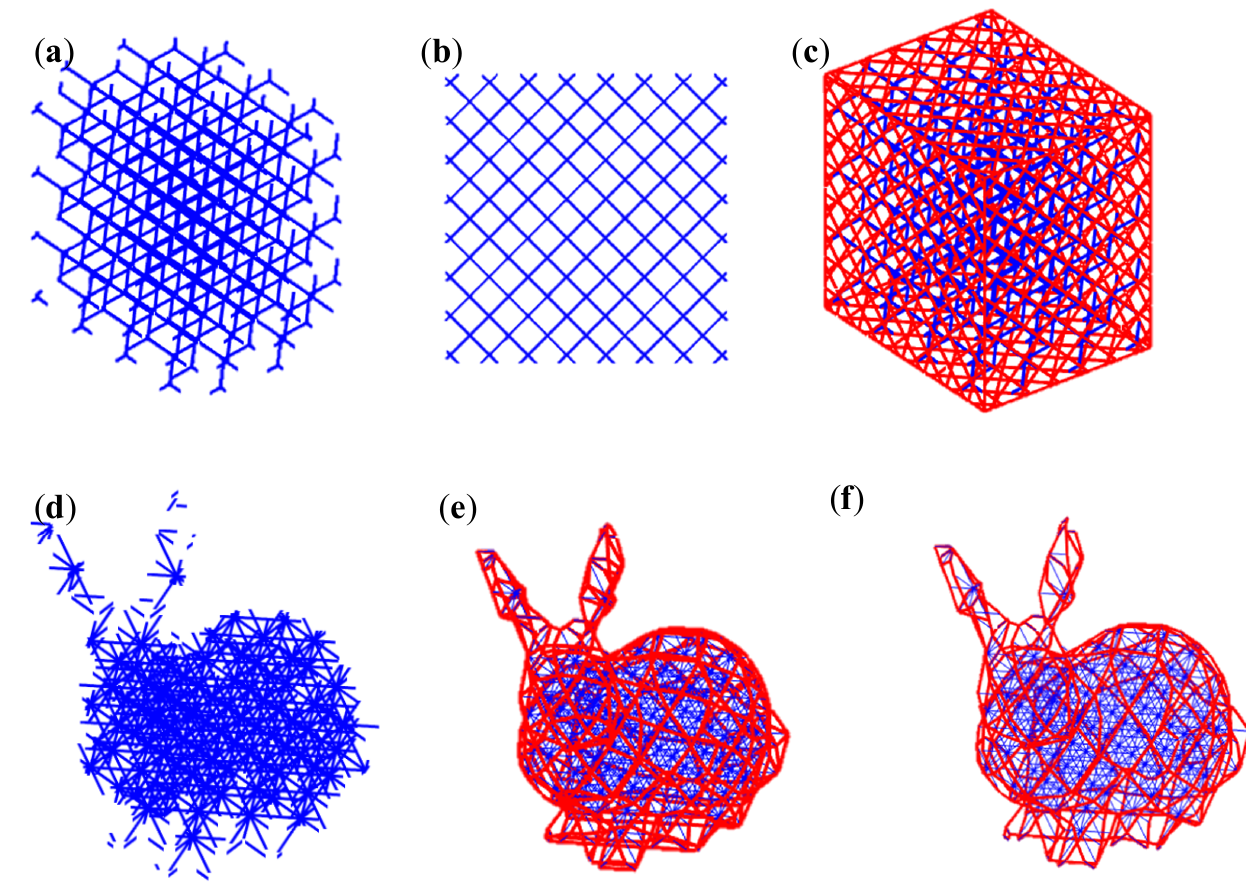
Figure 13. ( a ) Interior diamond lattice, ( b ) front view of diamond lattice, ( c ) diamond lattice net using {110}, ( d ) bunny interior of octet truss, ( e ) octet truss lattice net with {111}, and ( f ) octet truss lattice net with no filter and planes ((cid:2778)(cid:2778)(cid:2778)), ((cid:2778)(cid:2778)(cid:2778)), ((cid:2778)(cid:2778)(cid:2778)) .